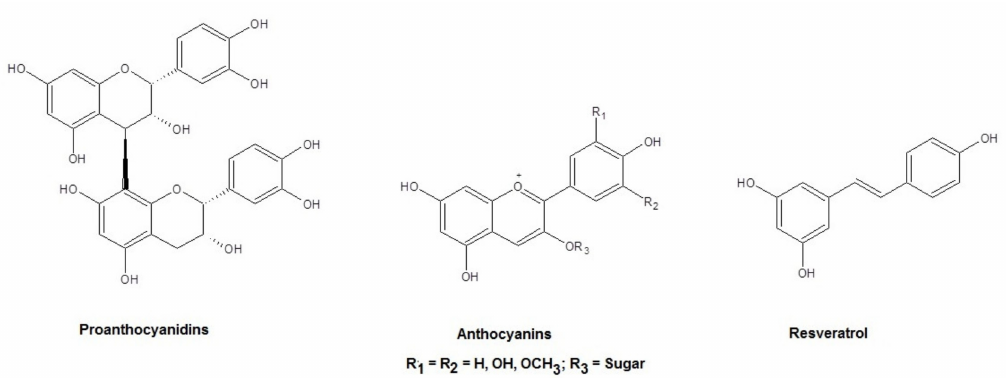
Figure 1. Chemical structures of the main polyphenol compounds represented in grape seed